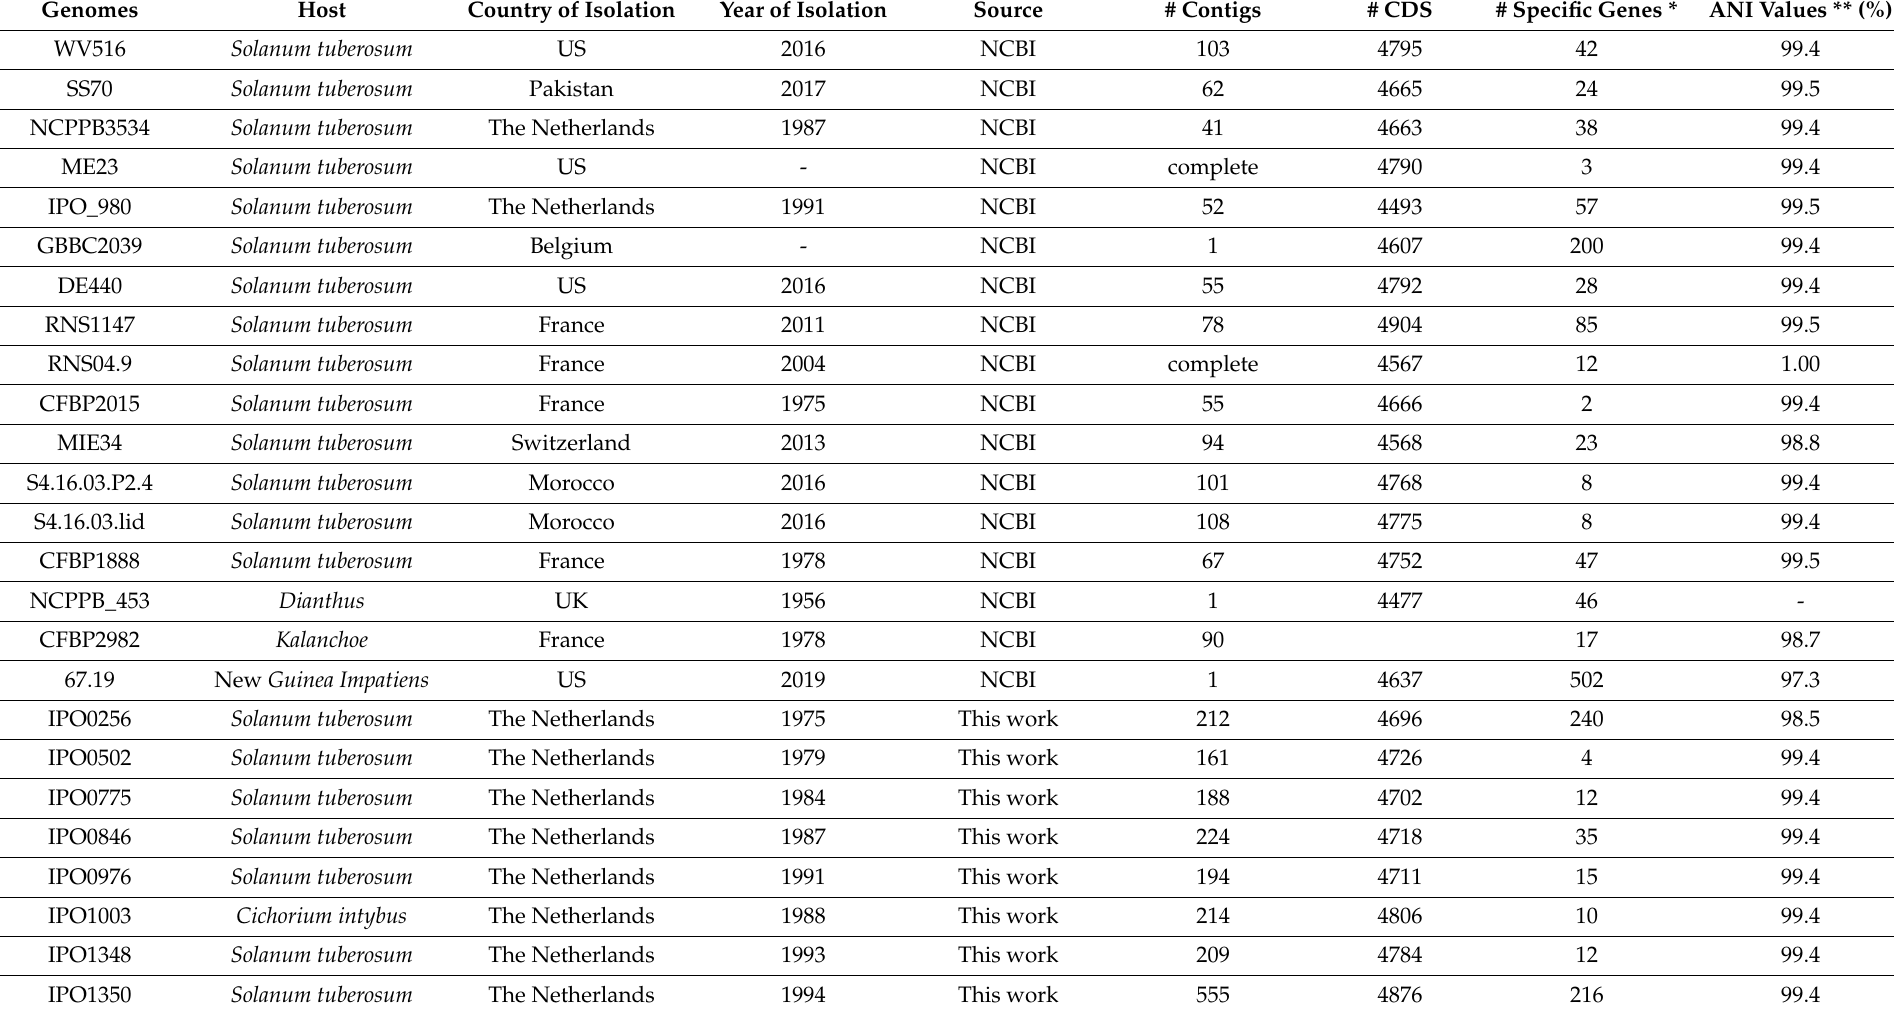
Table 1. Genomes of D. dianthicola analysed in this